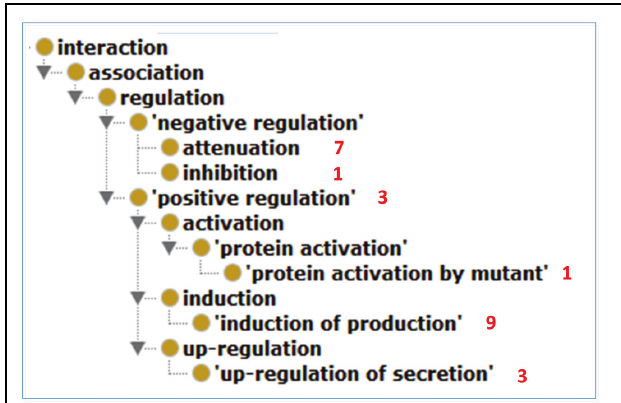
FIGURE 5 | The ontology hierarchy of literature mined INO interaction types. In total, six different INO interaction types were identified from this literature mining study. The number of interactions of a specific type is shown in red next to the interaction type. The ‘induction of production’ type is the most common type identified.